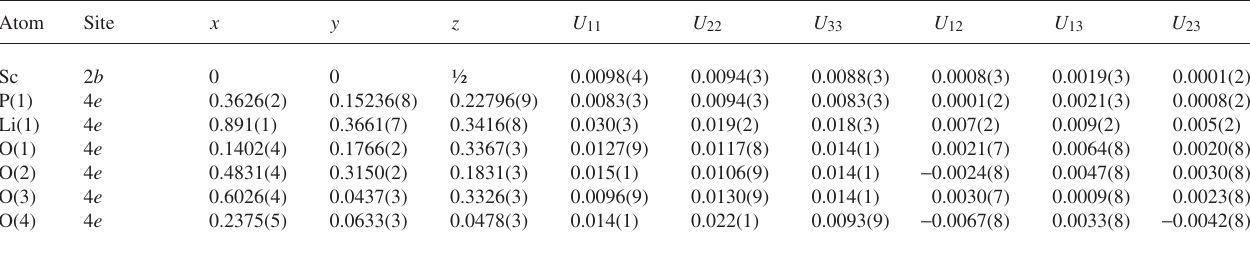
Table 2. Atomic coordinates and displacement parameters (in Å 2 )